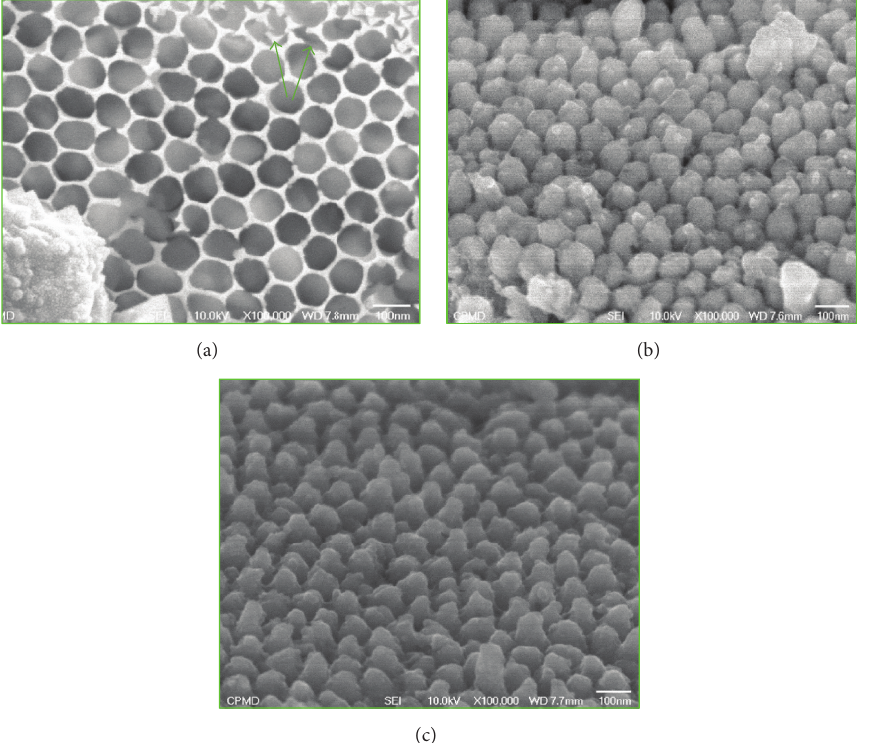
Figure 2: Top view FE-SEM images of (a) PAA membrane pore widened for 70 min and electrodeposited with Au at 5 mA and 57 ∘ C for 3 min and PAA membranes pore widened for 60 min and electrodeposited at the same conditions for (b) 4min and (c) 6